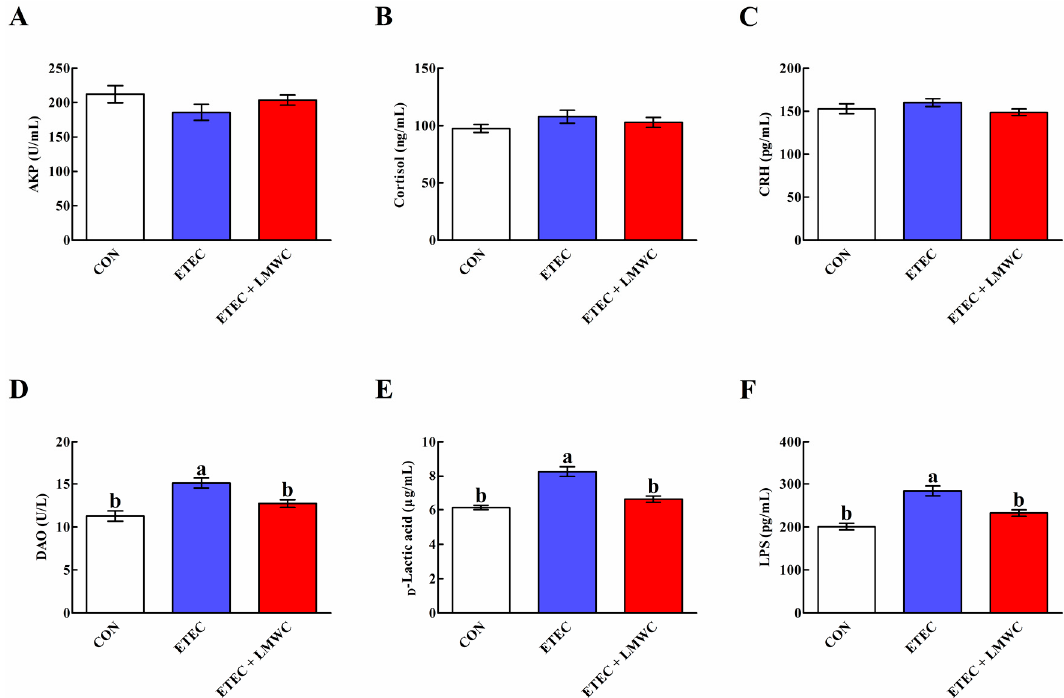
Figure 2. Effects of low-molecular-weight chitosan on the serum indices in weaned pigs challenged with enterotoxigenic Escherichia coli . ( A ) AKP, alkaline phosphatase. ( B ) Cortisol. ( C ) CRH, corticotropin-releasing hormone. ( D ) DAO, diamine oxidase. ( E ) D -Lactic acid. ( F ) LPS, lipopolysaccharide. a, b Means with different letters on vertical bars indicate significant differences ( P < 0.05). Values are means ( n = 8 pigs/treatment), with standard errors represented by vertical bars. CON: non-infected control (pigs that received a basal diet infused with sterilised Luria–Bertani culture); ETEC: ETEC-infected control (pigs that received the basal diet infused with enterotoxigenic Escherichia coli ); ETEC + LMWC: pigs that received the basal diet supplemented with 100 mg/kg low-molecular-weight chitosan and infused with enterotoxigenic Escherichia coli .